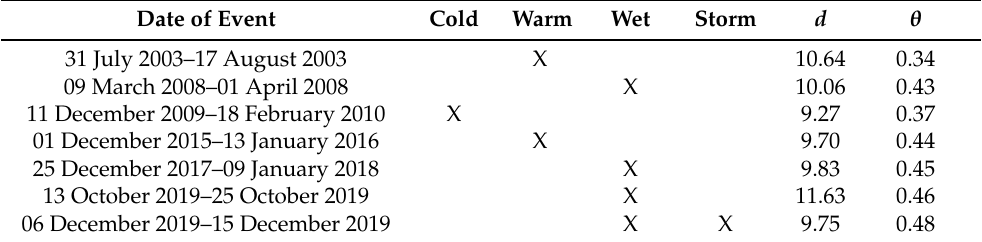
Table 2. Table of key extreme events in France since 2000. The median local dimension d and persistence metric θ (see Section 4 for definitions) are indicated for each